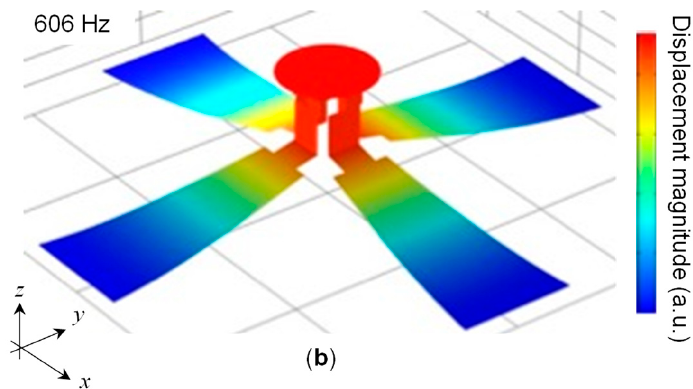
Figure 3. Result of the modal analysis: ( a ) First and ( b ) second resonant mode shapes.